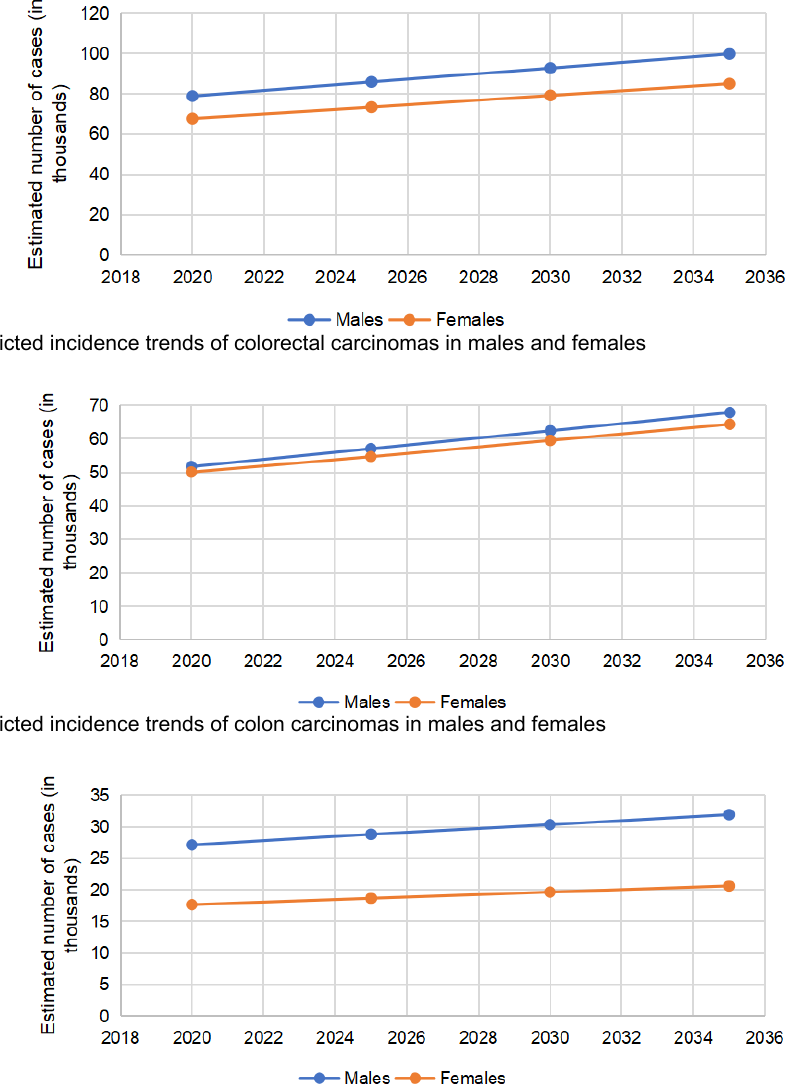
Figure 3. Predicted incidence trends of rectal carcinomas in males and